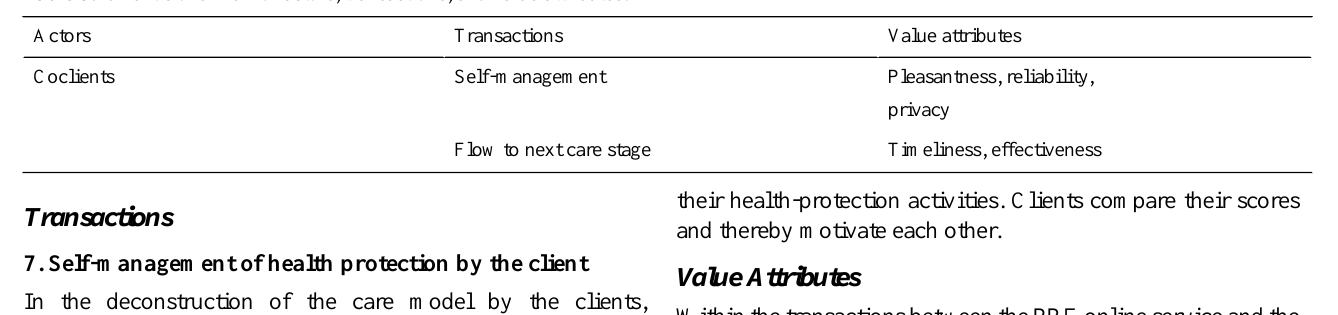
Table 5. Client’s overview of actors, transactions, and value